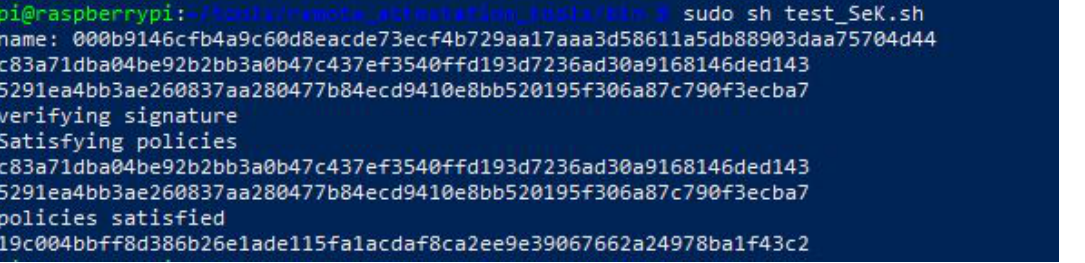
Figure 4. Output of the script using the sealed key to sign a measured value after satisfying the